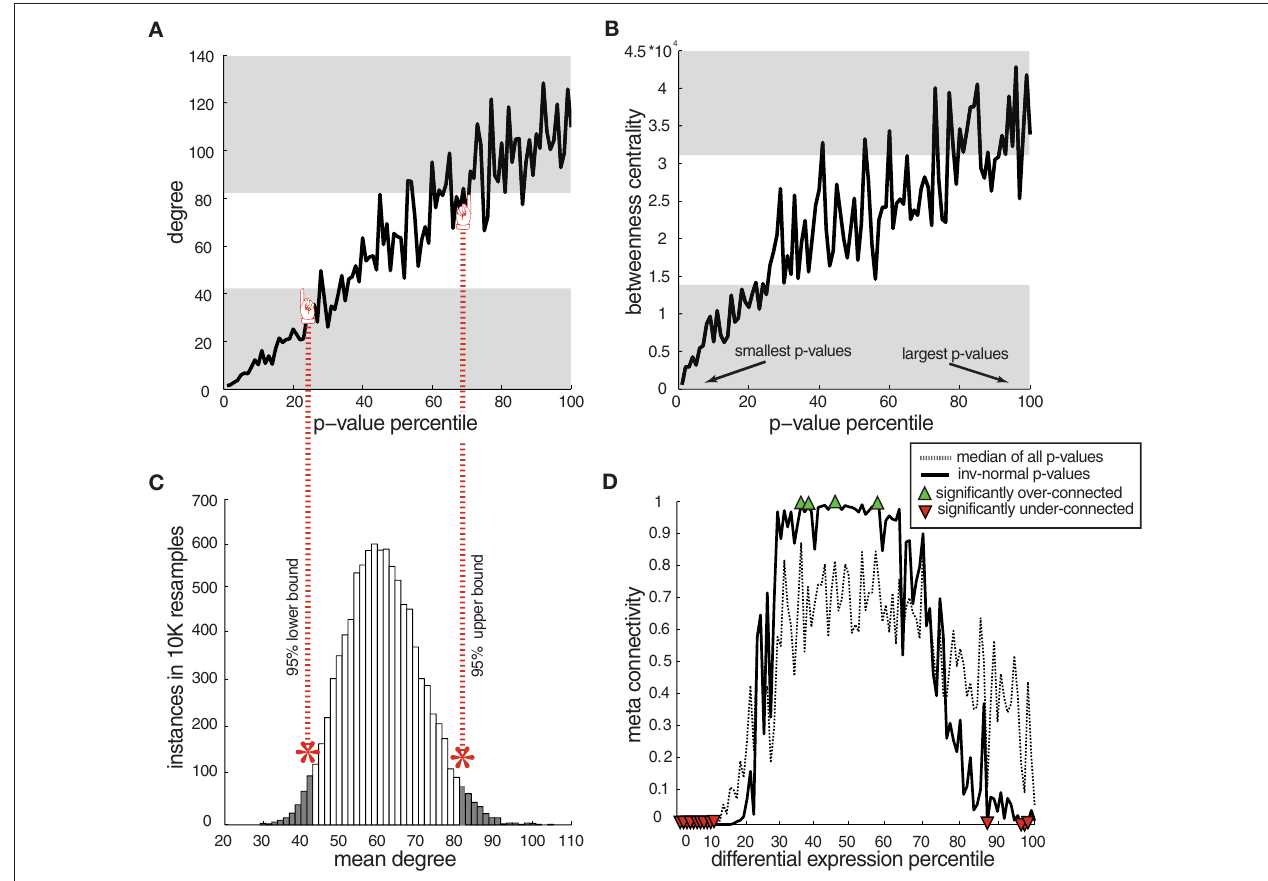
node is by all shortest network paths) by p -values in amygdala indicates that the DE genes are not merely low-connected, but on the edge of the network, because low p -value genes have the lowest betweenness centrality. (C) An example of a null connectivity distribution is used to estimate the expected range of connectivity – each network has its own specific null distribution used to estimate bounds on expected connectivity. (D) Combined p -value by degree trends for all datasets (spanning species, disease, and array platforms). Meta-connectivity values close to 0 indicate less connectivity than expected for that percentile of DE genes in all datasets. Percentiles with non-random connectivity were estimated at alpha = 0.05 and 10%